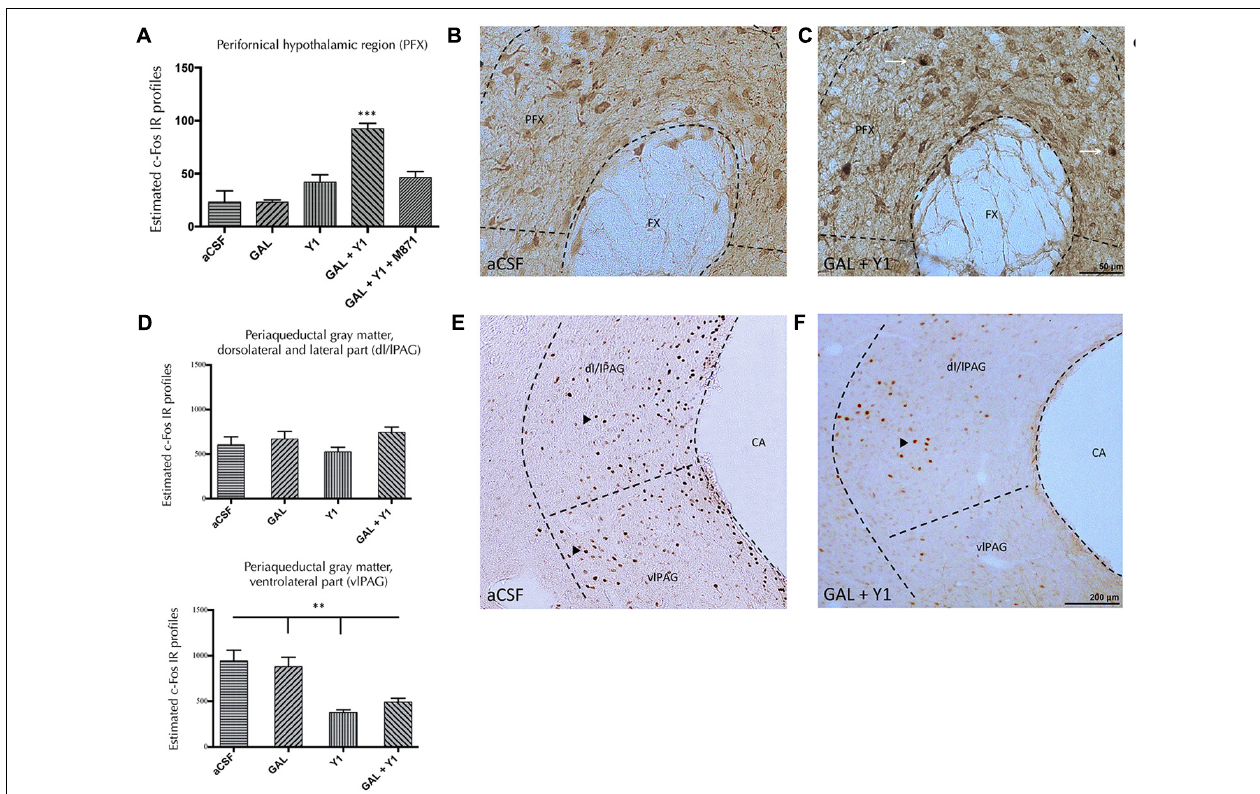
FIGURE 6 | Effects of Galanin (GAL) and NPYY1R agonist alone, together or in combination with the GAL 2 receptor (GALR2) antagonist M871, on c-Fos expression in the perifornical region (PFX) and periaqueductal gray (PAG) region. Quantification of total c-Fos IR nuclei in PFX (A) and PAG, dorsolateral/lateral (dl/lPAG) (D , Top ) and ventromedial (vmPAG) (D , Bottom ) subregions. Data, expressed as mean ± SEM show the differences between groups after intracerebroventricular injections of aCSF, GAL, [Leu 31 -Pro 34 ]NPY, both peptides or the coadministration of both peptides and M871. (A) The coadministration of GAL and the NPYY1 agonist increased the c-Fos expression in the PFX compared with the infusion of each peptide alone and the aCSF group. Moreover, this effect was blocked by the GALR2 antagonist M871. ∗∗∗ P < 0.001 GAL+Y1 versus the rest of the groups according to one-way ANOVA followed by Newman–Keuls Multiple Comparison Test. N = 4 in each group. Sections were double immunostained with Calbindin. GAL and NPYY1R agonist coinjection (C) increased the c-Fos expression in calbindinergic neurons in the PFX compared with the control group (B) . Dashed lines represent measuring fields around upper region of fornix (FX). White arrows indicate neurons that are c-Fos+/Calbindin+. [Bregma: –3.14 mm; according to the Paxinos and Watson (1986) stereotaxical atlas]. After infusion of GAL, NPYY1 agonist or the combination no differences were observed on c-Fos IR profiles in the dl/lPAG (D , Top ) . However, NPYY1 agonist and the coadministration with GAL decreased c-Fos expression specifically in the vlPAG compared with GAL alone and the aCSF group (D , Bottom ) . ∗∗ P < 0.01 according to one-way ANOVA followed by Newman–Keuls Multiple Comparison Test. Inter-group comparisons are indicated by the lines above bars. C-Fos IR value for GAL+Y1+M871 group on dl/lPAG was 543.8 ± 63.6 and on vmPAG 498 ± 44.57. Representative microphotographs show how the coadministration of both peptides GAL and NPYY1R agonist (F) decreased the c-Fos expression in the vlPAG compared with the control group (E) . Dashed lines represent measuring fields around the cerebral aqueduct (CA). Black arrowheads indicate c-Fos IR profiles. [Bregma: –7.8 mm; according to the Paxinos and Watson (1986) stereotaxical atlas]. Abbreviations: aCSF, cerebrospinal fluid; GAL, Galanin 3 nmol; Y1, NPY Y1 receptor agonist [Leu 31 -Pro 34 ]NPY 2,5 nmol; GAL+Y1, Coadministration of GAL and [Leu 31 -Pro 34 ]NPY;